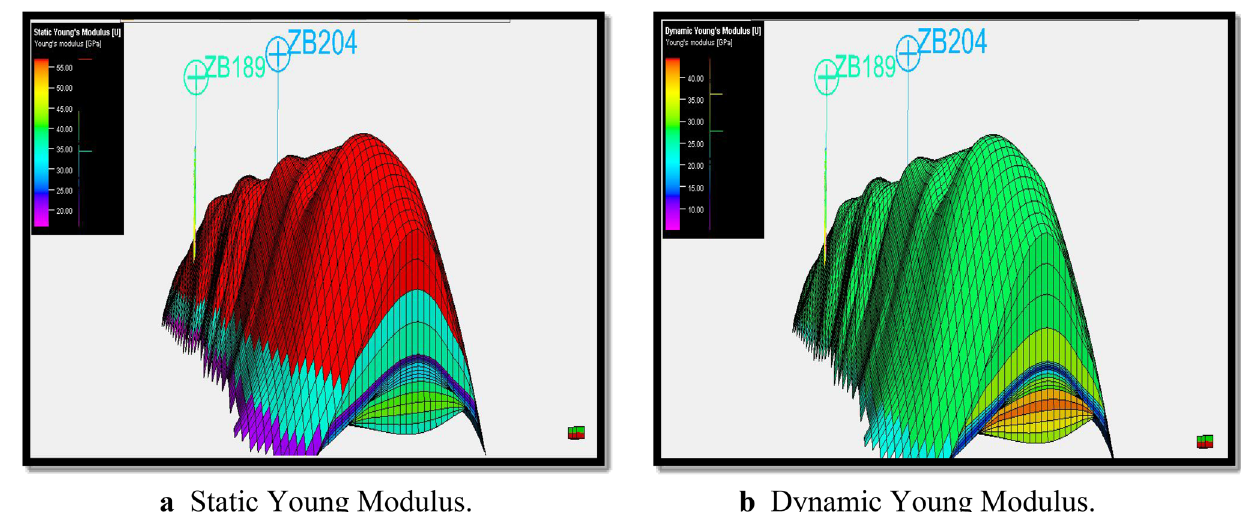
Fig. 16 Static and dynamic Young’s modulus